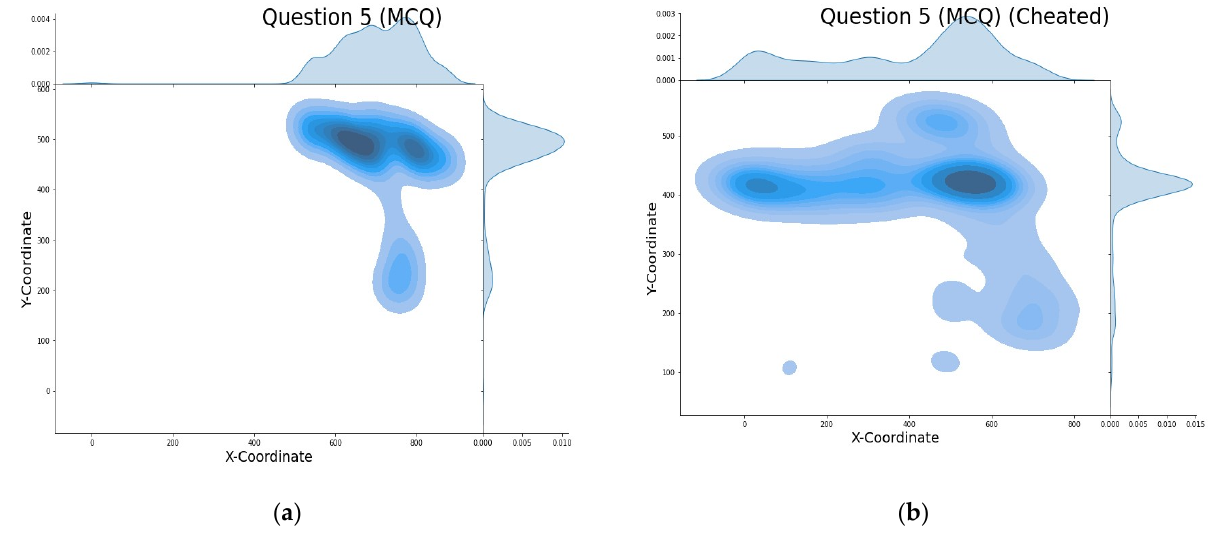
Figure 9. 2-d KDE plot showing the density distribution of raw mouse cursor movements of students as follows: ( a ) a KDE plot of question 5 answered by students without cheating; ( b ) a KDE plot of question 5 answered by students who are allowed to cheat.